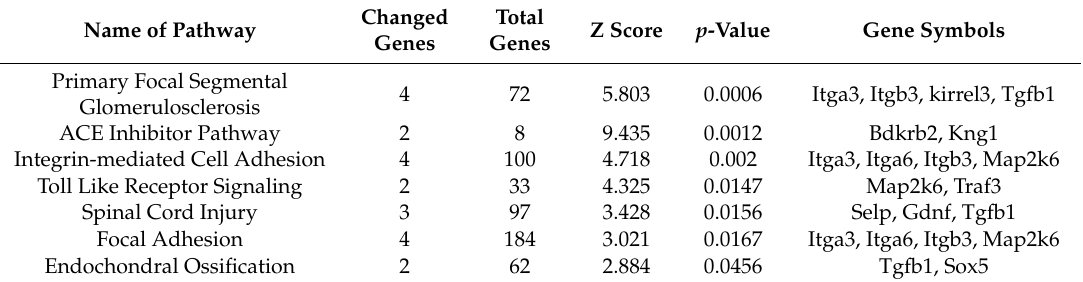
Table 1. Pathways upregulated on the Me-PRX surfaces.